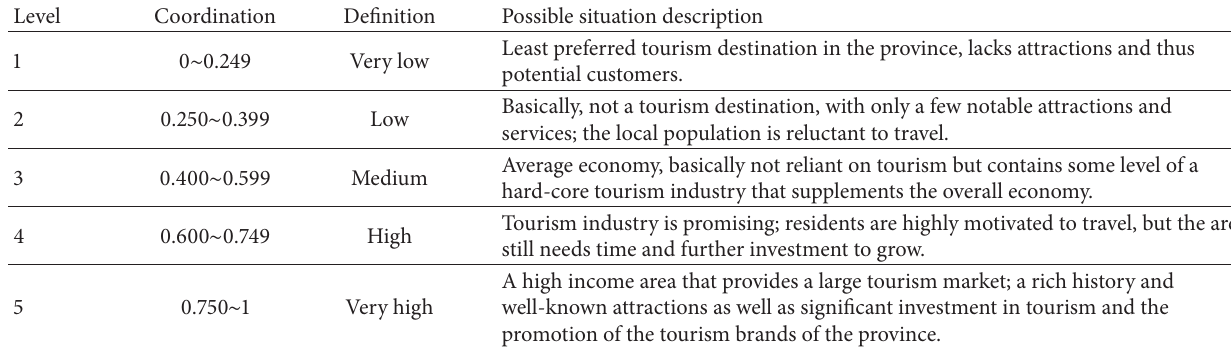
Table 3: Classification of coordination